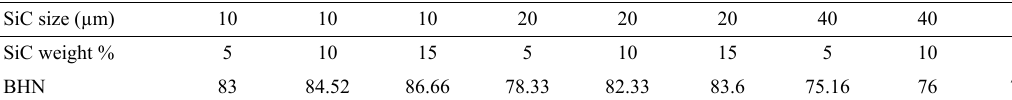
Table 2. Composition of Aluminium MMC with hardness